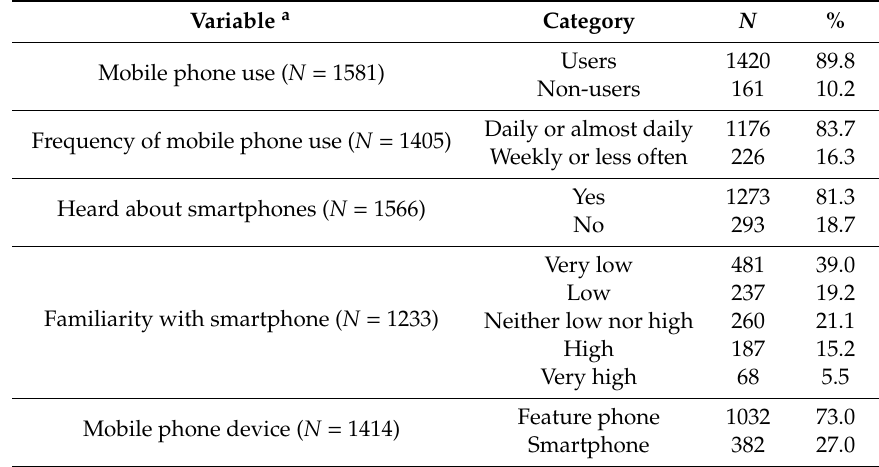
Table 2. Mobile phone and smartphone usage sample characteristics.